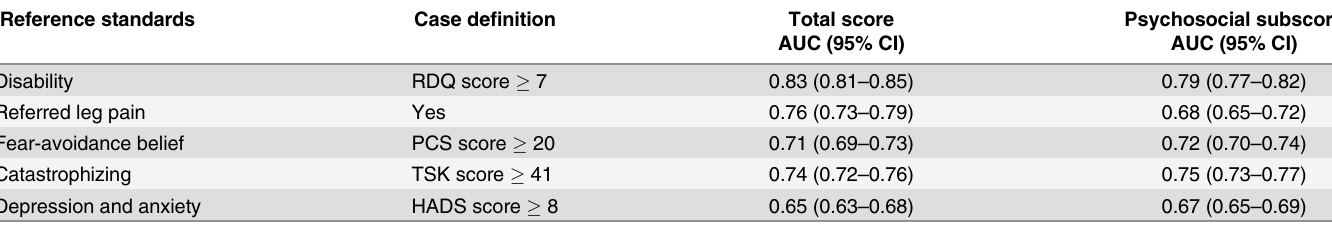
Table 4. AUCs for STarT-J total score and psychosocial subscore against reference standards.